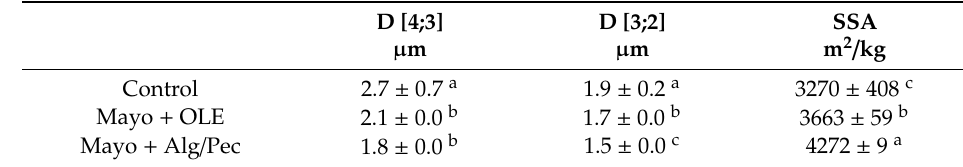
Table 1. Particle size parameters of mayonnaise samples after preparation, as affected by olive leaf phenolic extract (OLE) and alginate/pectin (Alg/Pec) + OLE enrichment.